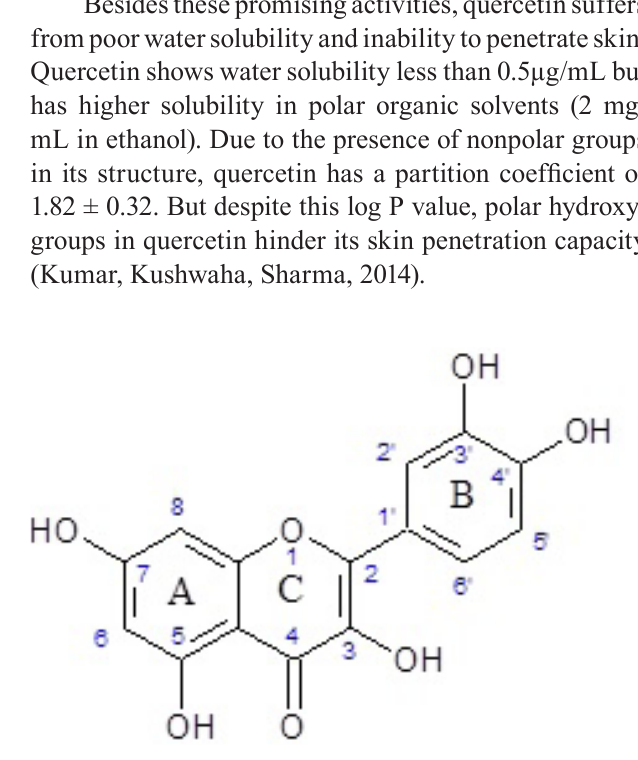
FIGURE 3 - Structure of